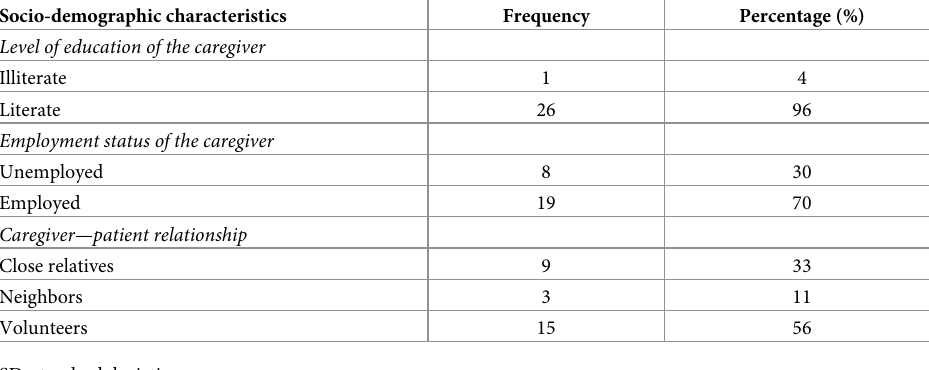
Table 2. Socio-demographic characteristics of caregivers (n =